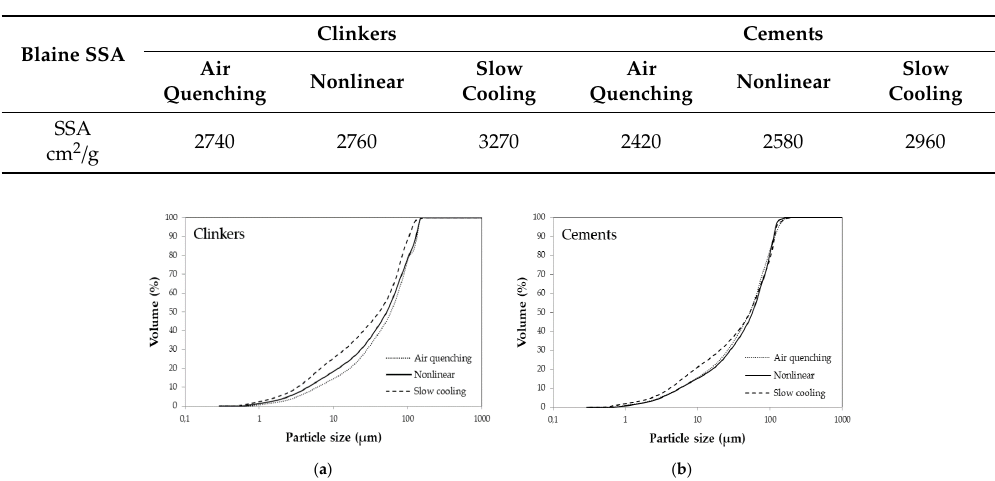
Figure 1. Particle size distribution (PSD) of the ground clinkers ( a ) and prepared cements ( b ) as determined by laser diffraction (Microtrac SYNC Model 5001, Microtrac Retsch GmbH, Haan, Germany; dry operation,).